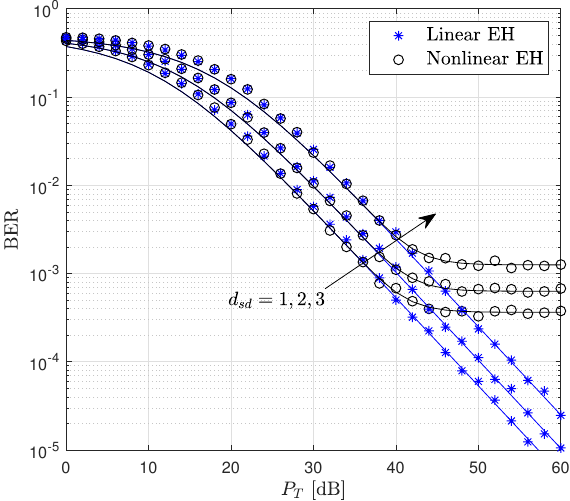
Figure 5. BER performance of the WP DH AF relaying system versus P T dB where P th = 35 dB.